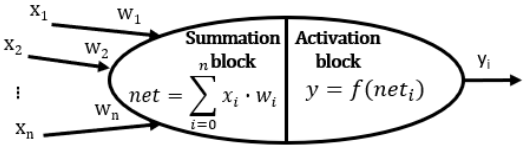
Figure 5. McCulloch and Pitts artificial neuron model [27] Figure 5 . McCulloch and Pitts artificial neuron model [27] . Figure 5 . McCulloch and Pitts artificial neuron model [27] .